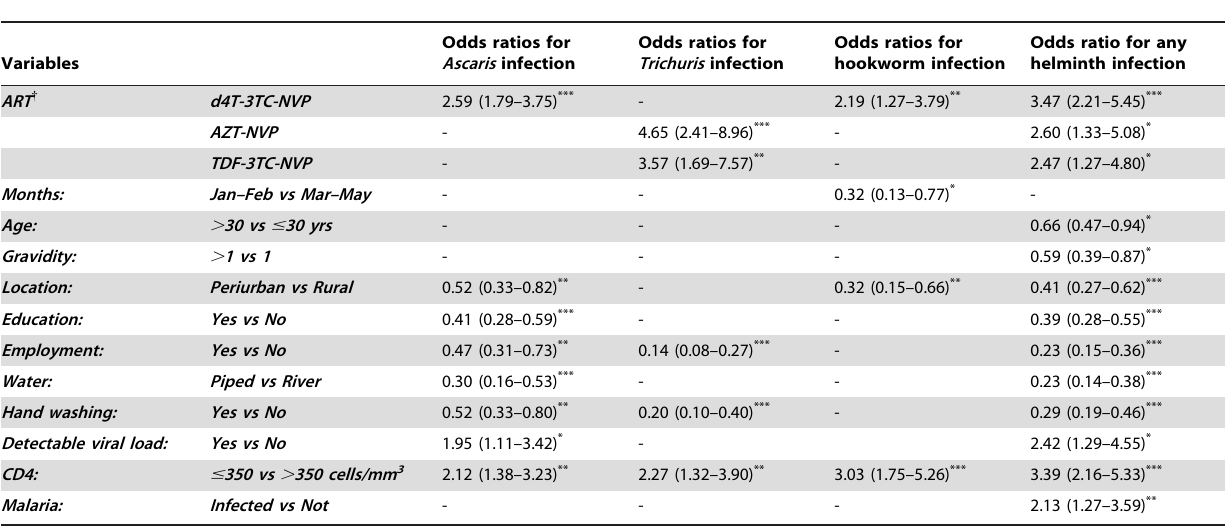
Table 3. Multiple logistic regression analyses to identify risk factors for helminth infections.